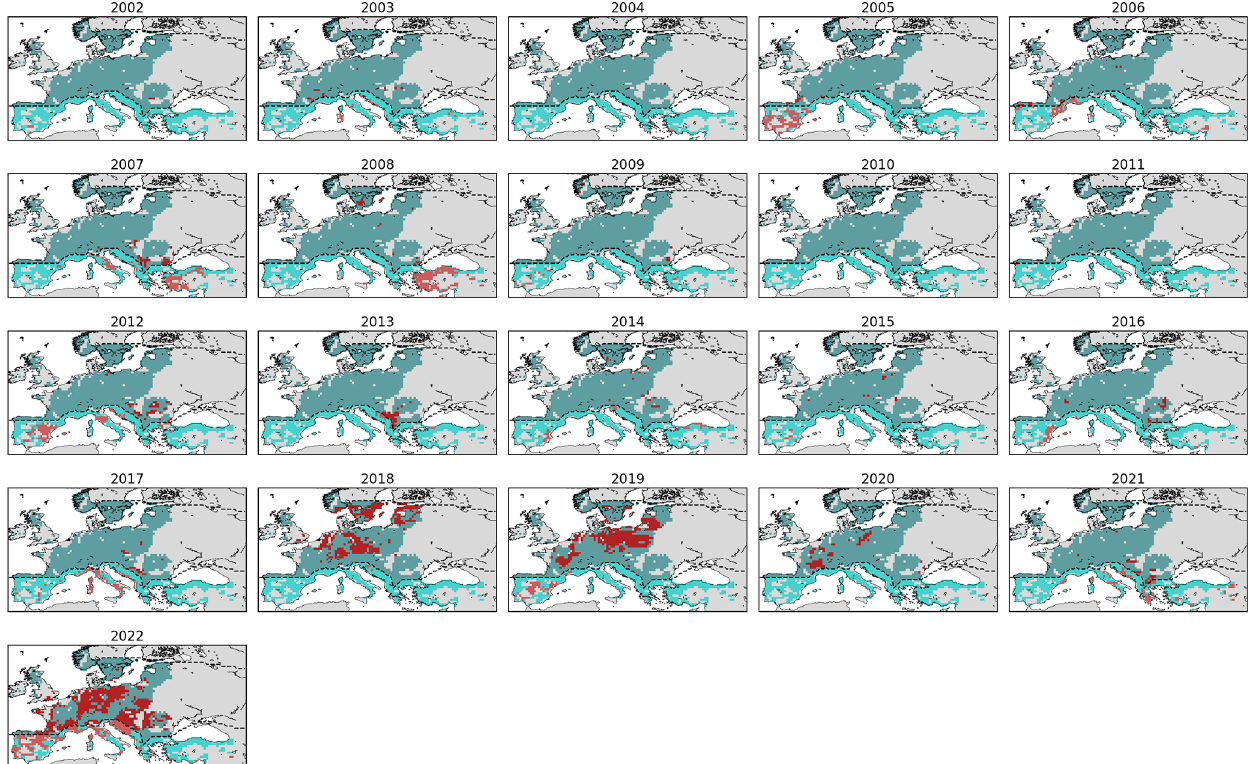
Figure C1. Low-NDVI grid cells in 2002–2022 (red) in forest grid cells of the temperate (turquoise) and Mediterranean biome (cyan). The dashed lines delineate the two